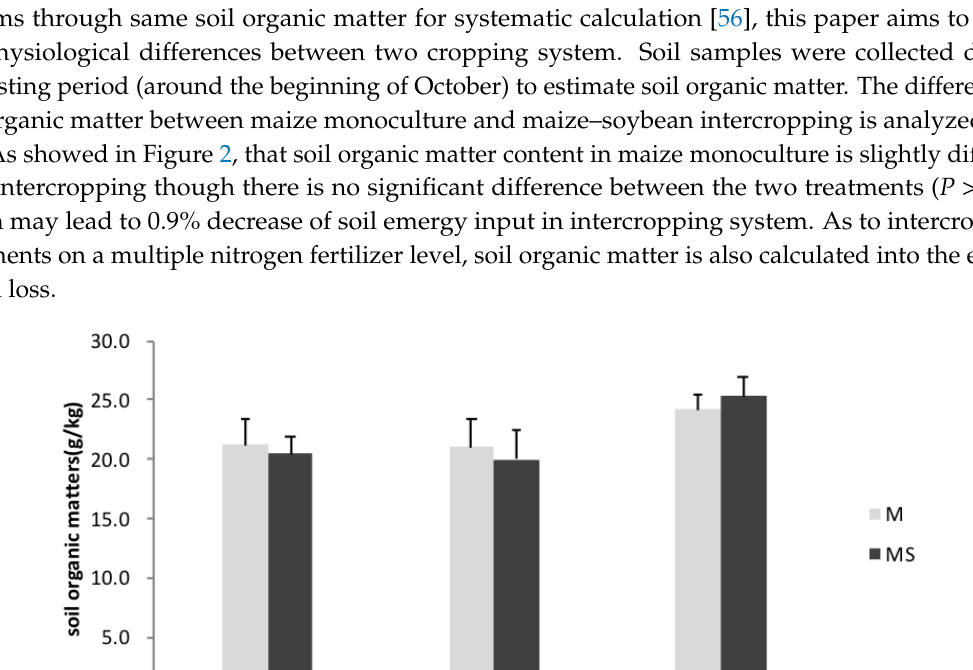
Table 2. UEV and RNF applied in this study.